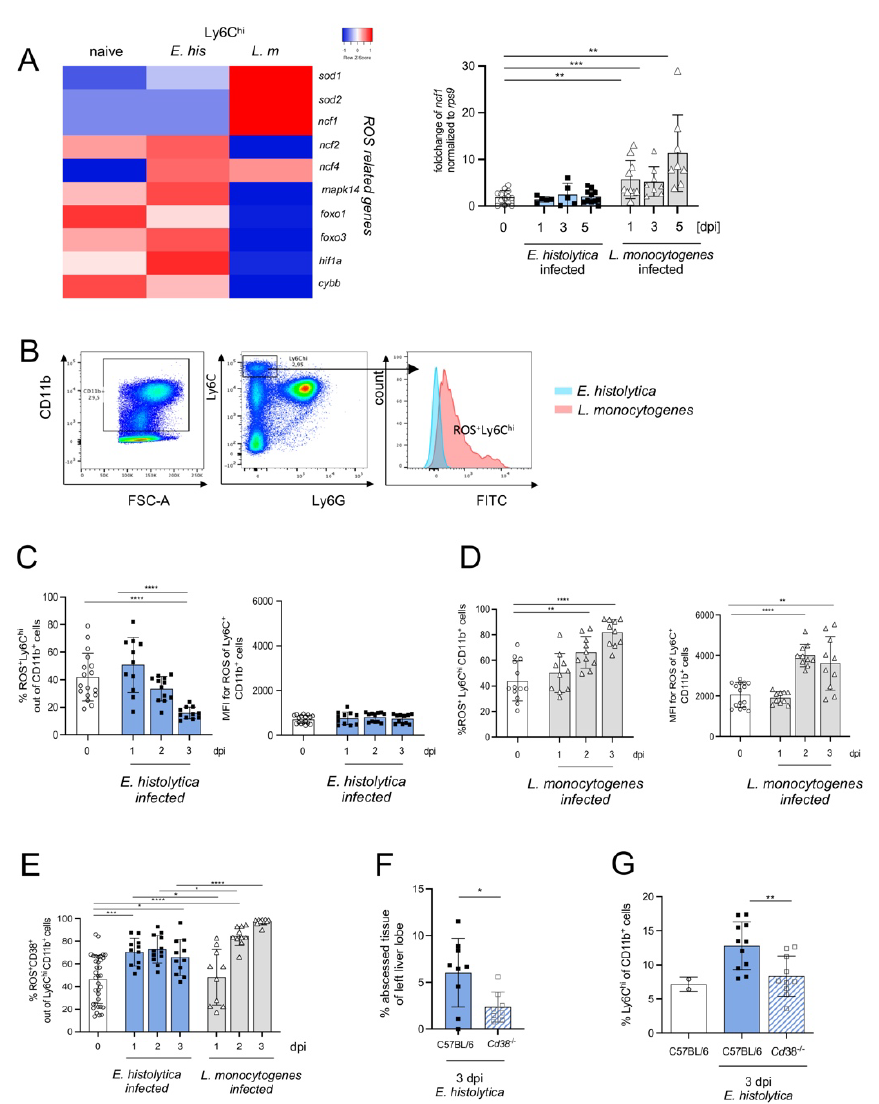
Figure 6. CD38 + Ly6C hi monocytes represent the major monocytic source of ROS production and contribute to liver damage following E. histolytica infection. ( A ) Heat map of differentially regulated genes involved in ROS production and a graph showing fold changes in expression of Ncf1 mRNA in the liver during infection with E. histolytica or L. monocytogenes . ( B ) Gating scheme and histogram for ROS + liver Ly6C hi monocytes. Percentage and mean fluorescent intensity (MFI) of ROS + Ly6C hi monocytes during ( C ) E. histolytica and ( D ) L. monocytogenes infection. ( E ) Percentage of ROS + CD38 + out of Ly6C hi CD11b + monocytes in both infection models. ( F ) Percentage of amebic liver abscess weight in relation to the left liver lobe in WT (C57BL/6) and Cd38 -/- mice. ( G ) Percentage of Ly6C hi CD11b + cells in the liver in naive, infected WT and Cd38 -/- mice. (* p < 0.05; ** p < 0.01; *** p < 0.001; **** p < 0.0001; Mann-Whitney U